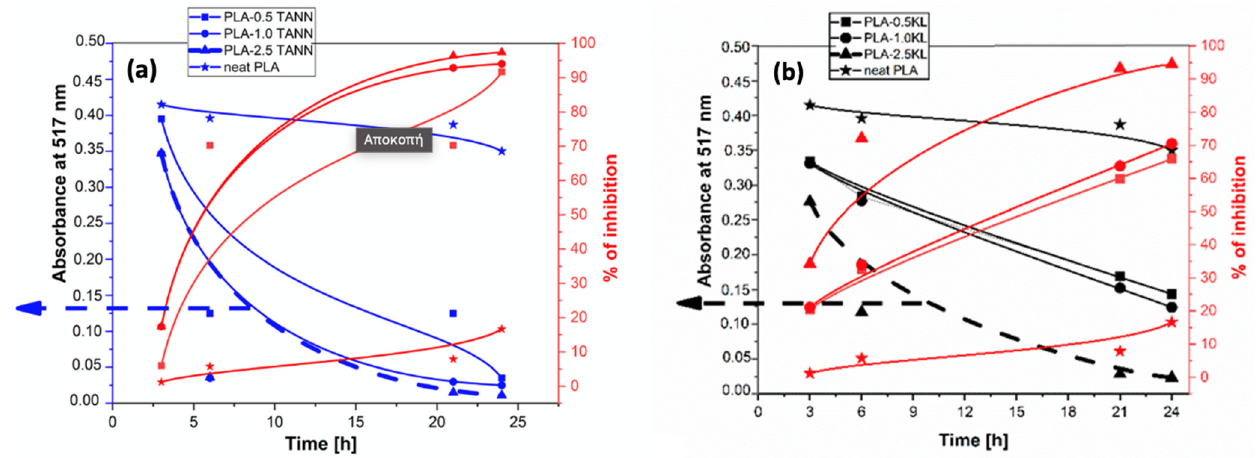
Figure 10. Reaction kinetics and % of inhibition of the PLA-based ( a ) TANN and ( b ) KL composites film evaluated with DPPH radical scavenging in the methanol solution indicated after 24 h